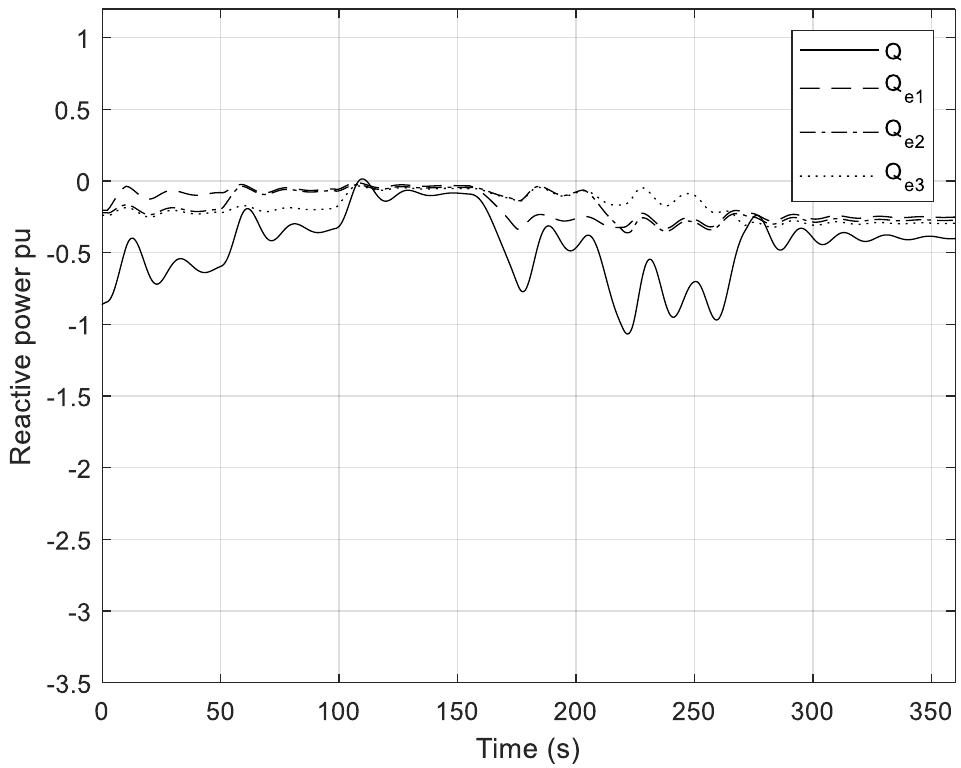
Figure 18. Current of the B2B converter and currents of PMSGs.